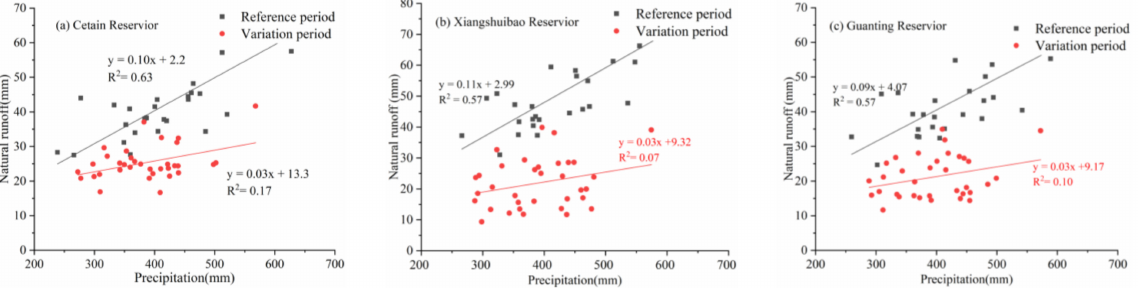
Figure 3. Relationship between annual rainfall and natural runoff of main and tributaries in the mountain area of Yongding River. ( a ) the relationship between annual rainfall and natural runoff in the control basin of Cetian reservior; ( b ) the relationship between annual rainfall and natural runoff in the control basin of Xiangshuibao reservior; ( c ) the relationship between annual rainfall and natural runoff in the control basin of Guanting